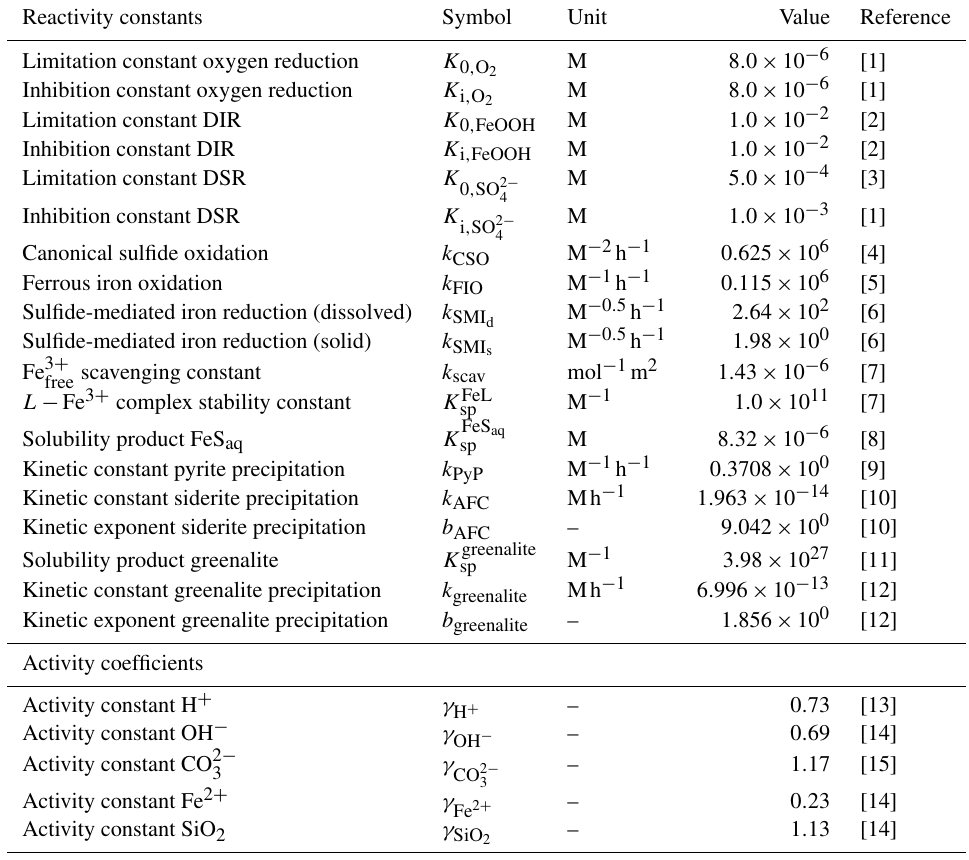
Table 3. List of kinetic constants for the reactions included in the cGENIE model. Note that the units are not identical to the units used in the user configuration files for the cGENIE model. A table with the parameter units converted to cGEnIE units is included in Appendix